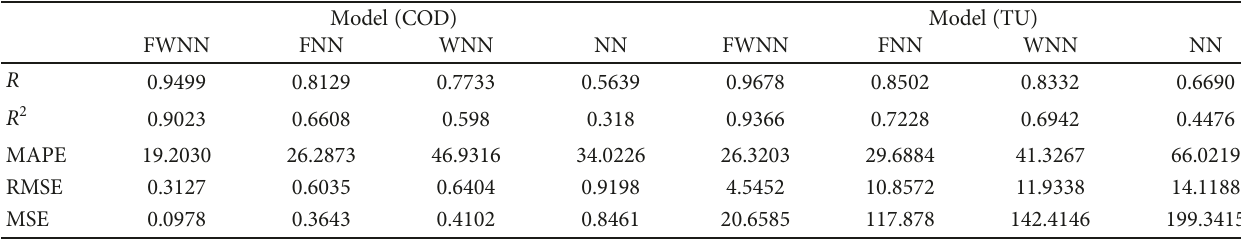
Figure 6: FWNN performance of the estimation of water quality for turbidity. Table 1: Performances of FWNN, WNN, and NN in modeling water quality